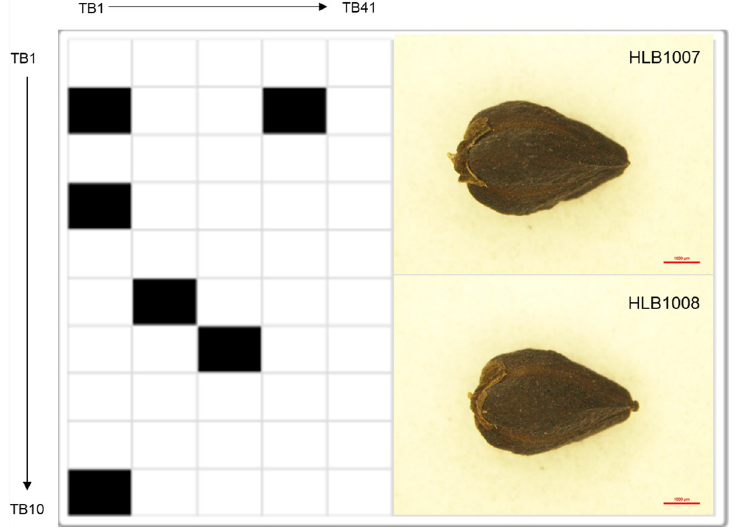
Fig 6. Comparison of 2-dimensional barcode patterns between HLB1007 and HLB1008. Identical results are represented by white, while the other results are represented by black. Seed morphology of HLB1007 and HLB1008.